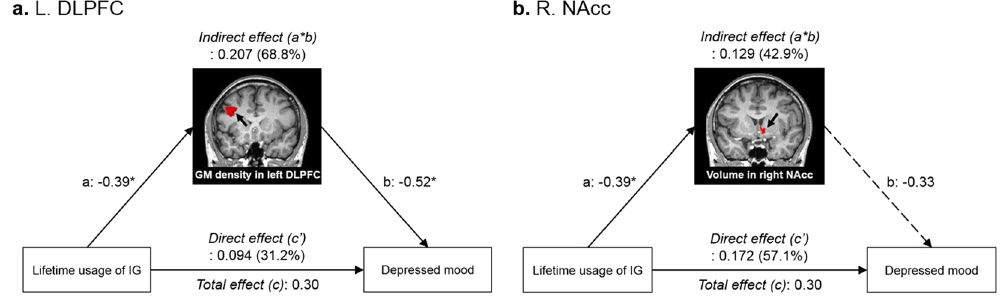
Figure 3. Mediation analysis to explore the neural substrates influencing the relationship between the lifetime usage of Internet gaming and depression. Structural alterations in ( a ) the left dorsolateral prefrontal cortex (DLPFC), not ( b ) right nucleus accumbens (NAcc), showed a mediating effect on the association between prolonged Internet gaming and depressed mood in the Internet gaming users. * Significant at P <